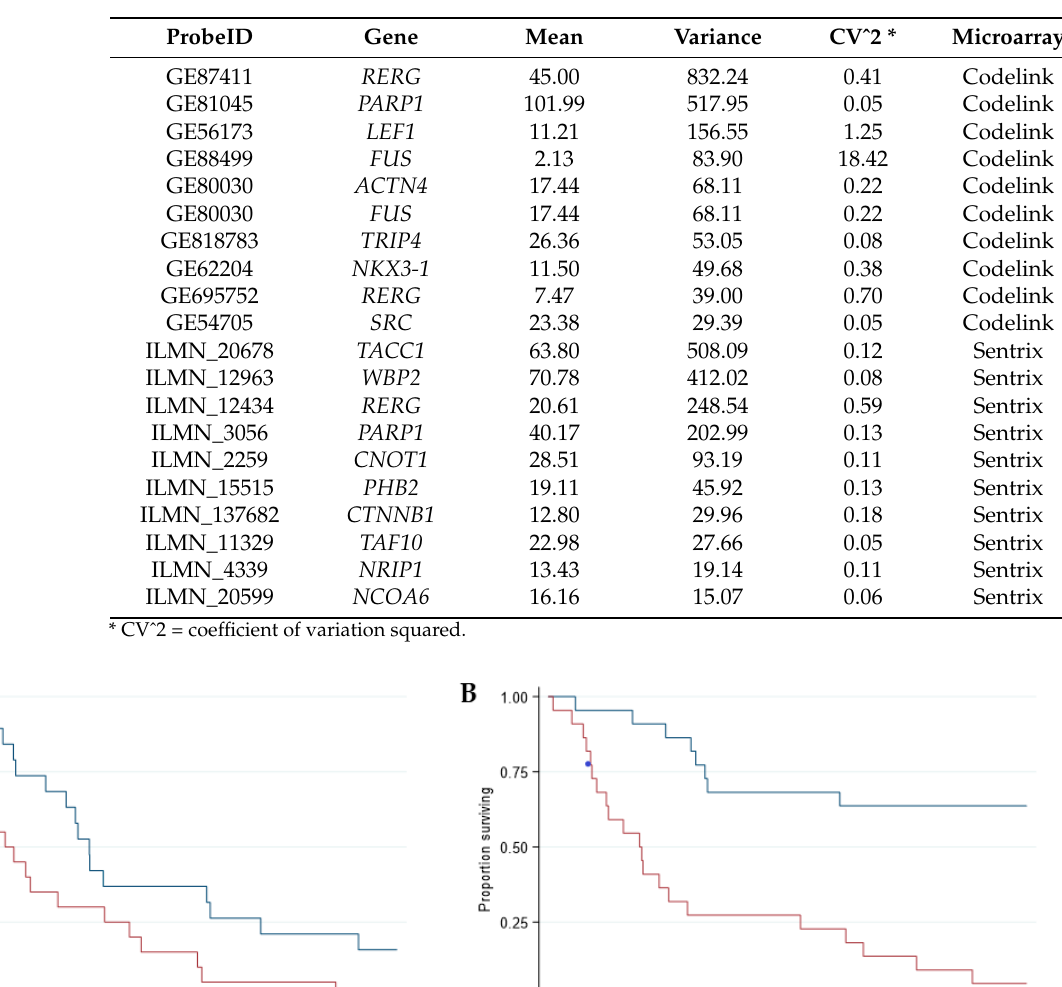
Table 1. The 10 most variable genes in the Estrogen Receptor Binding annotation of the Gene Ontology database using Codelink and Sentrix microarray data.